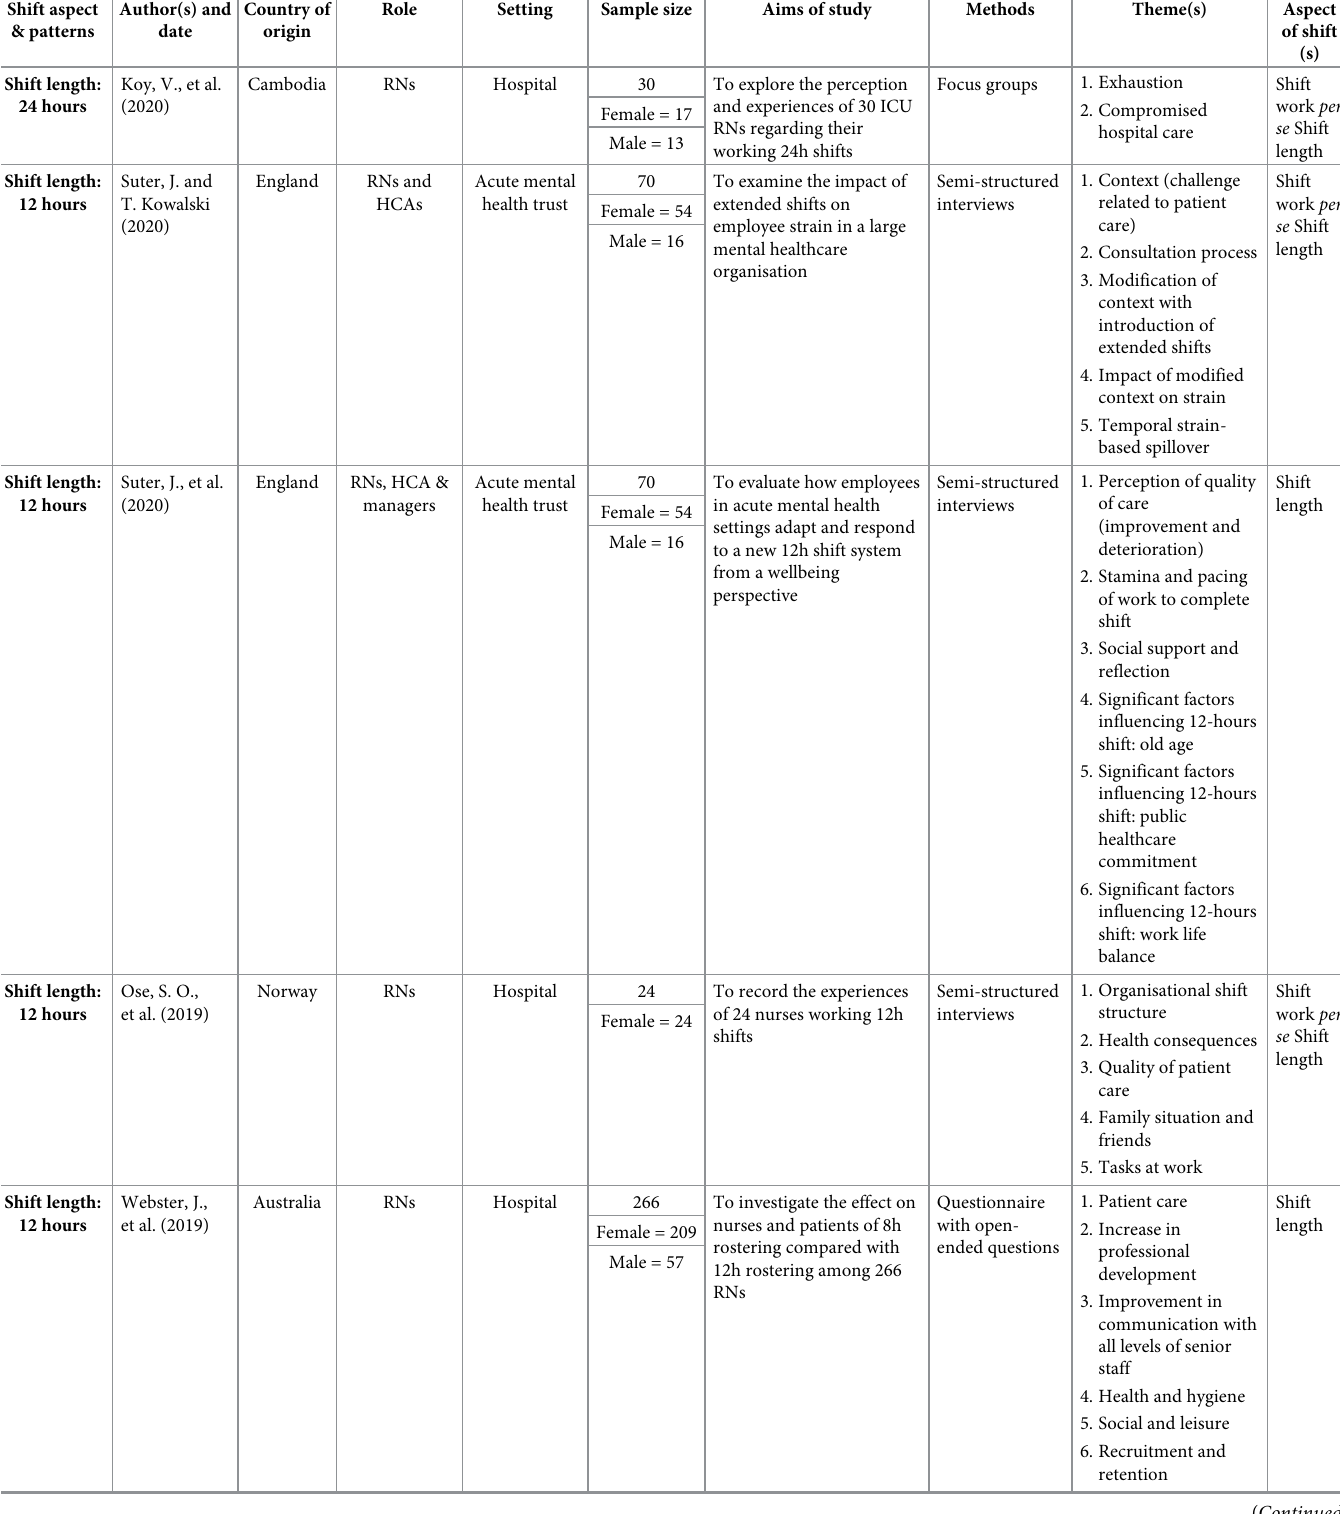
Table 2. Papers included in the scoping review (arranged by aspect of shift and descending chronological